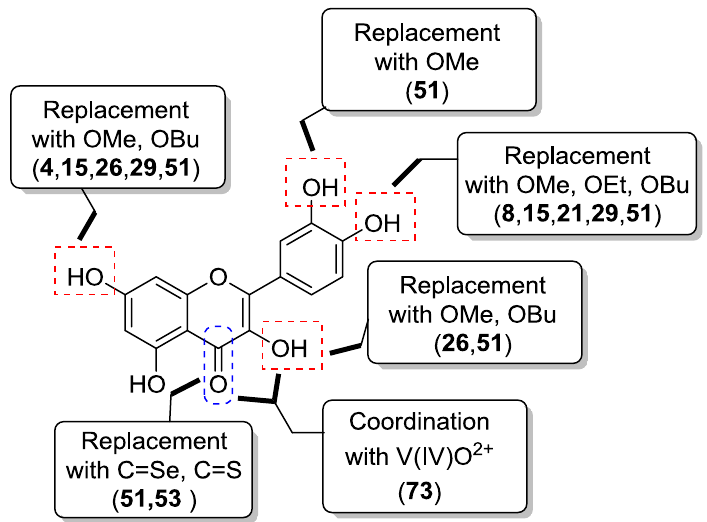
Figure 12. Structure modifications of quercetin leading to the most promising anticancer analogs. Table 19. Anticancer activity of the most promising quercetin analogs compared to quercetin 1 . Cell Line